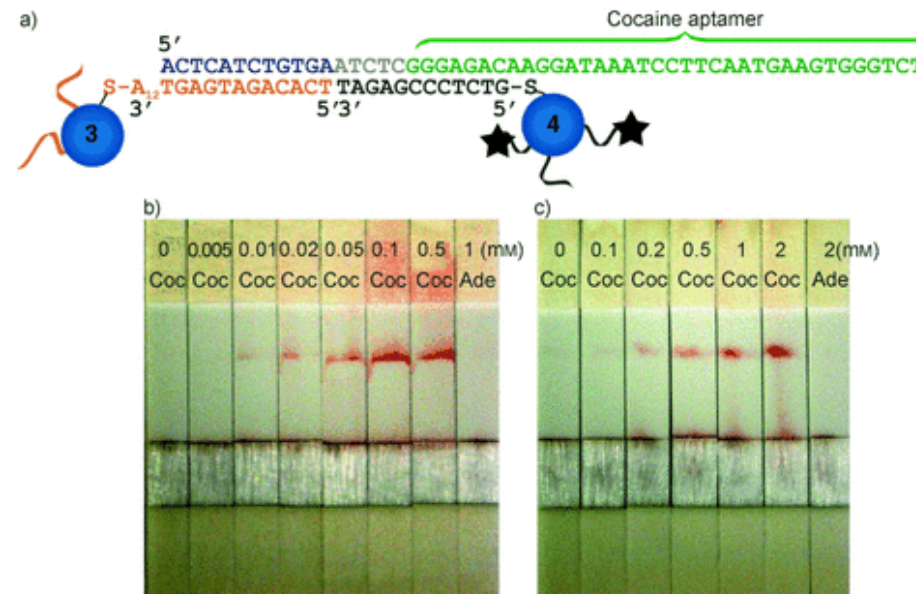
Figure 4. Lateral flow based detection of cocaine. ( a ) DNA sequences and linkages in cocaine aptamer-linked nanoparticle aggregates. Test of the cocaine-sensing lateral flow device with varying concentrations of cocaine in buffer solution ( b ) and in undiluted human blood serum ( c ). Coc=cocaine, Ade=adenosine. Reproduced with the permission of [109]. Copyright 2006 Published by Wiley-VCH.